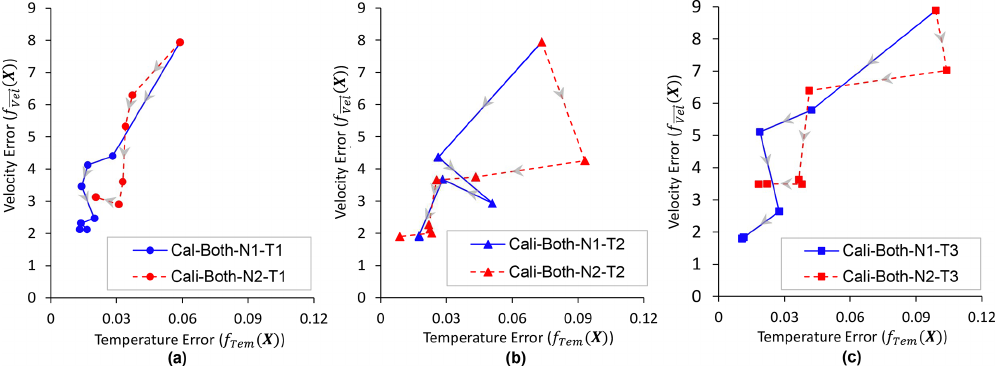
Figure 8. Calibration progress plot in terms of the best solution found during optimization search when using DYNO-N1 and DYNO-N2 as the objective function. Three random trials (T1, T2, and T3) are plotted in (a) – (c) . Lower velocity and temperature error are better. This figure uses the same format as Fig.